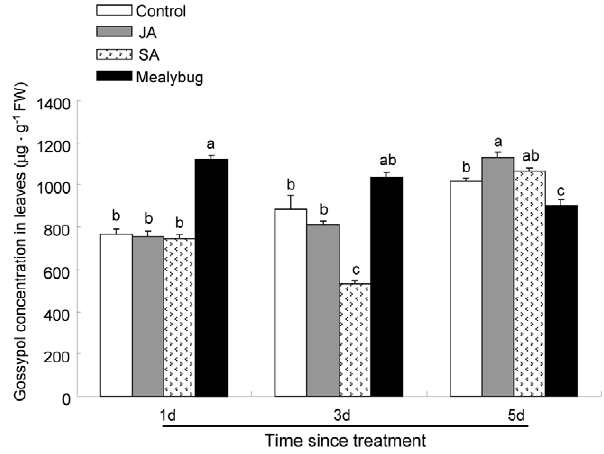
Figure 3. Performance of Phenacoccussolenopsis females reared on cotton plants from different treatments. Bars indicate means 6 SE; different letters indicate significant differences in the quantities between different treatments (Fisher’s PLSD test of ANOVA, P , 0.05). Control, undamaged plants; JA, plants sprayed with 1 mM JA solution; SA, plants sprayed with 1 mM SA solution; Mealybug, plants pre- infested with 50 of mix-aged P. solenopsis .